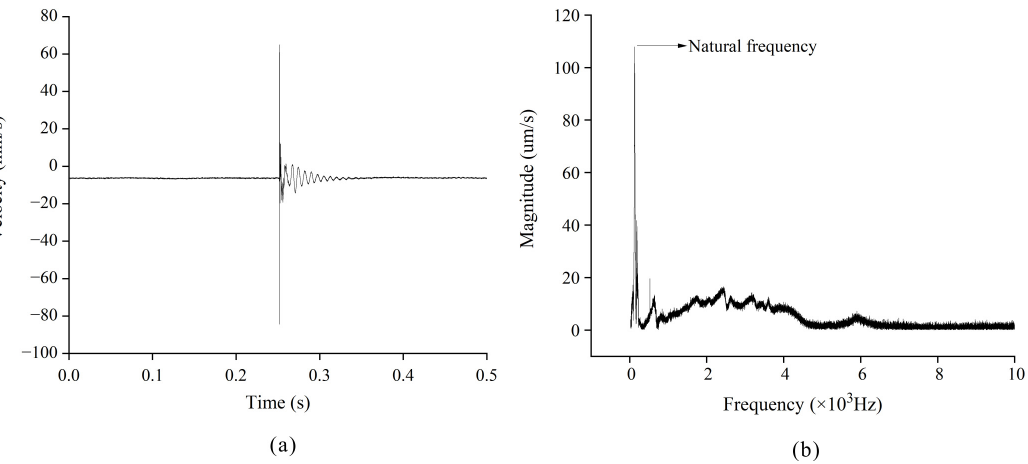
Figure 16. Acquisition of the natural frequency: ( a ) time ‐ domain illustration and ( b ) frequency ‐ domain illustration after a fast Fourier transform of the time ‐ domain diagram.